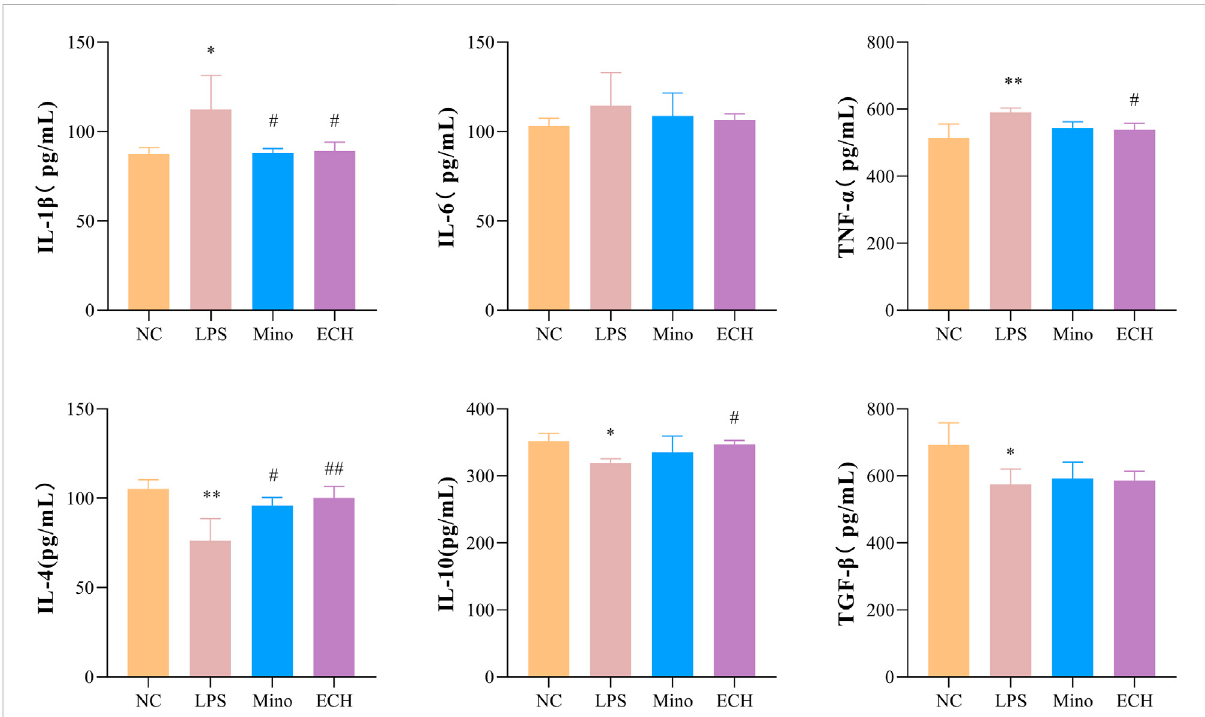
FIGURE 11 Effects of ECH on IL-1 β , IL-6, TNF- α , IL-4, IL-10, and TGF β levels in LPS induced N9 cells. NC, treated with equal amounts of medium; LPS, treated with 1 μ g/ml LPS; Mino, treated with 1 μ g/ml LPS and .1 μ M minocycline; ECH, treated with 1 μ g/ml LPS and 20 μ M echinacoside. n =